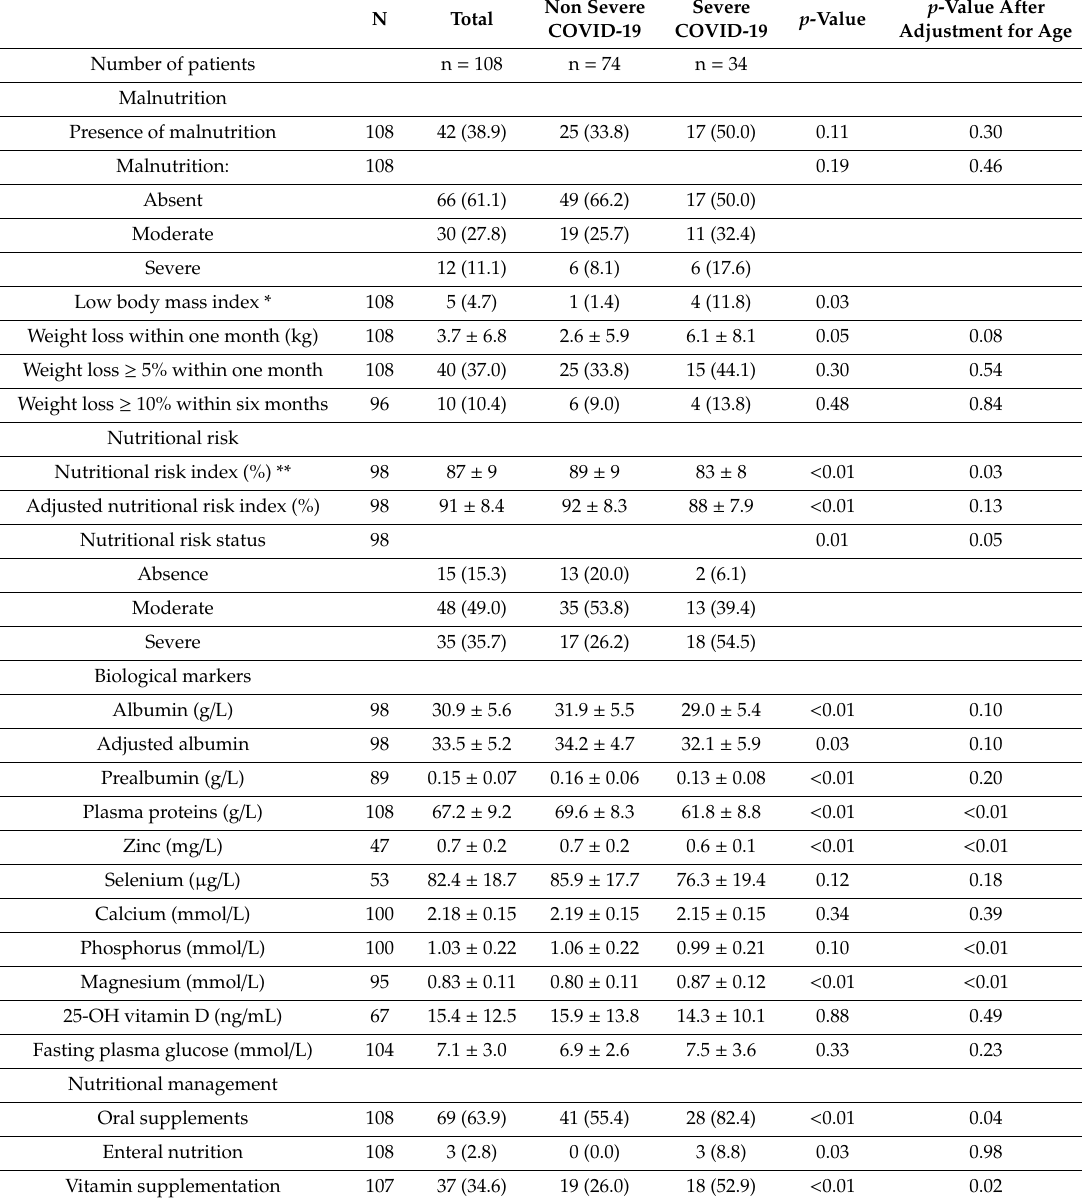
Table 4. Prognosis of malnutrition and nutritional